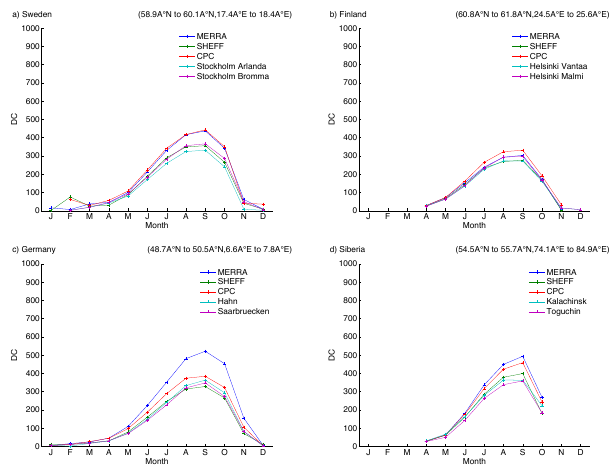
Figure 4. Monthly mean DC for northern Europe and Siberia. MERRA, SHEFF and CPC DC are from the GFWED gridded fields over the latitude and longitude range specified in the caption. The other two DC plots are for representative weather stations in that